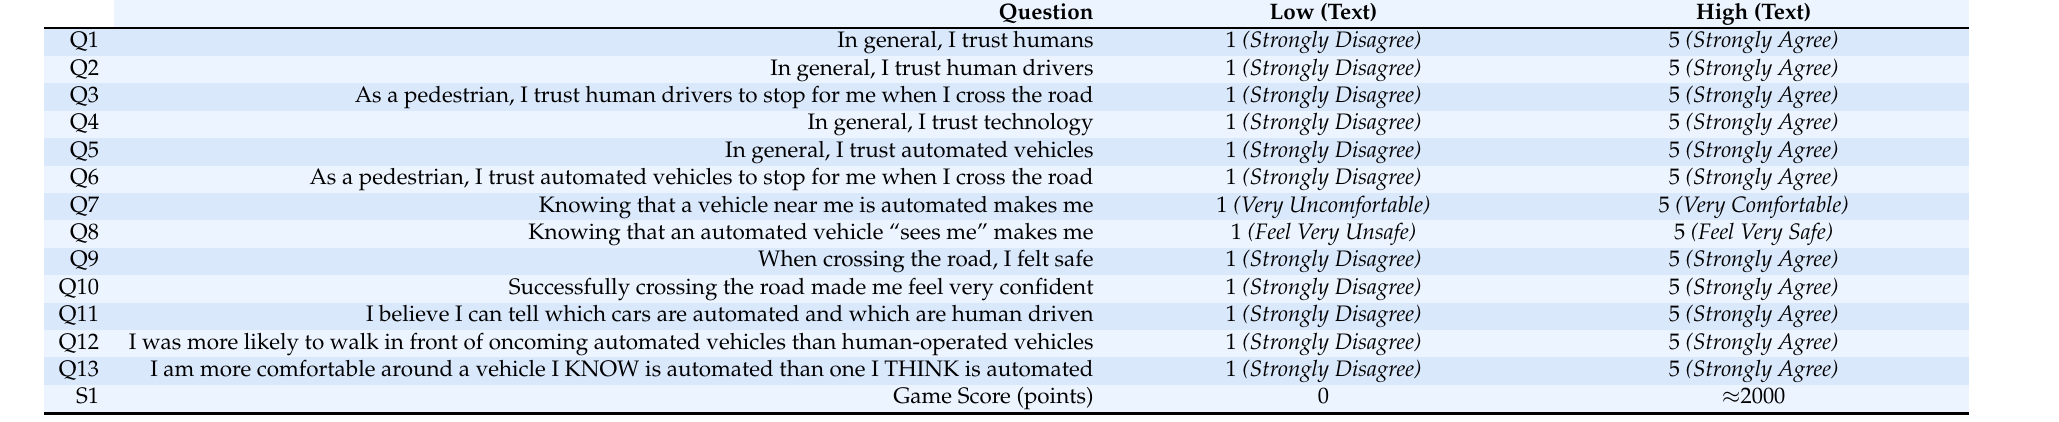
Table 3. Questions associated with the survey, as shortened in the results